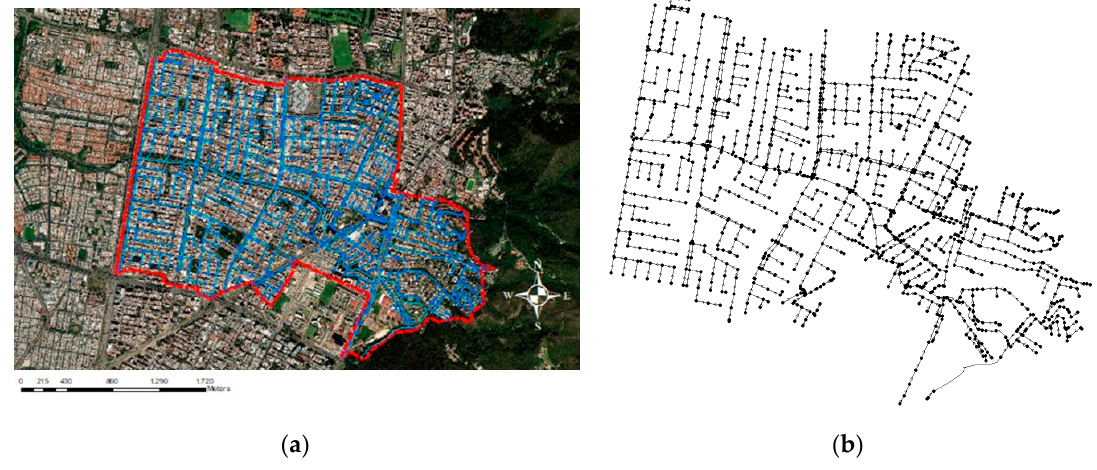
Figure 6. ( a ) Location of Northern Chicó Network. ( b ) SWMM for Northern Chicó Network.